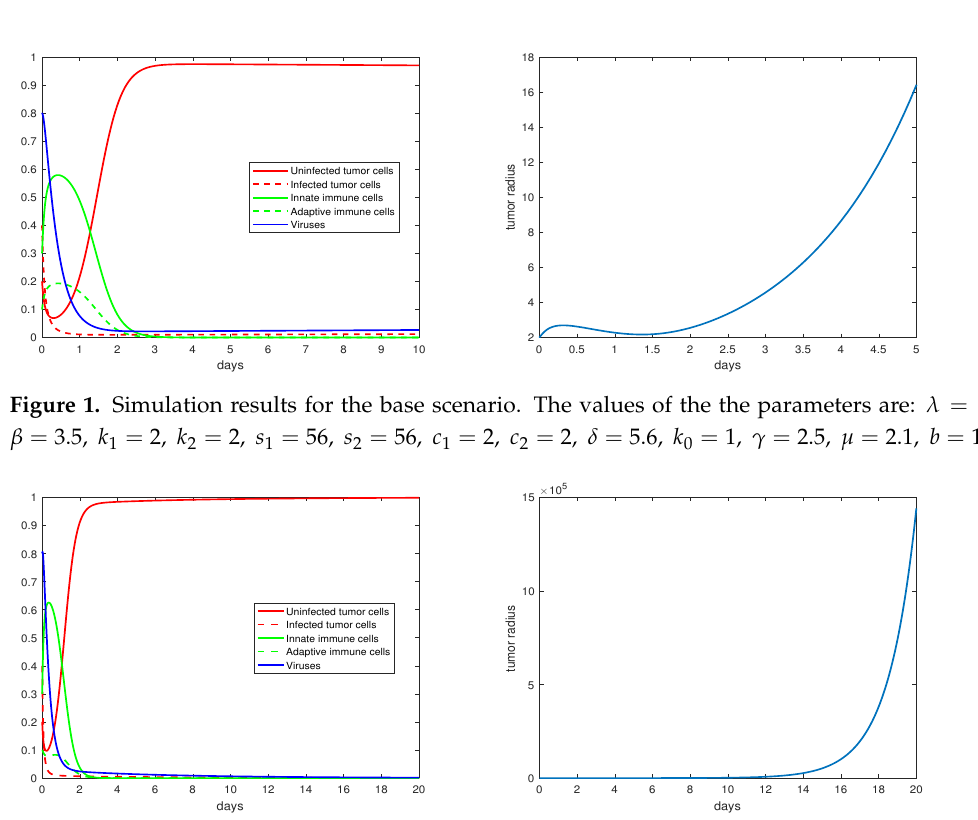
Figure 2. The equilibrium M 1 = ( 1,0,0,0,0 ) is asymptotically stable and the tumor radius is exponentially increasing when R 0 = 0.93 < 1. The values of the the parameters are: λ = 2, β = 3.5, k 1 = 1, k 2 = 2, s 1 = 60, s 2 = 20, c 1 = 2, c 2 = 1, δ = 10, k 0 = 1.5, γ = 2.5, µ = 2.5, b =